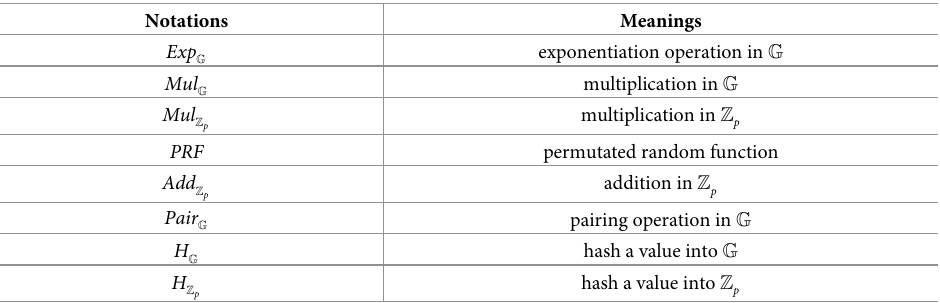
Table 2. Cryptographic notations.